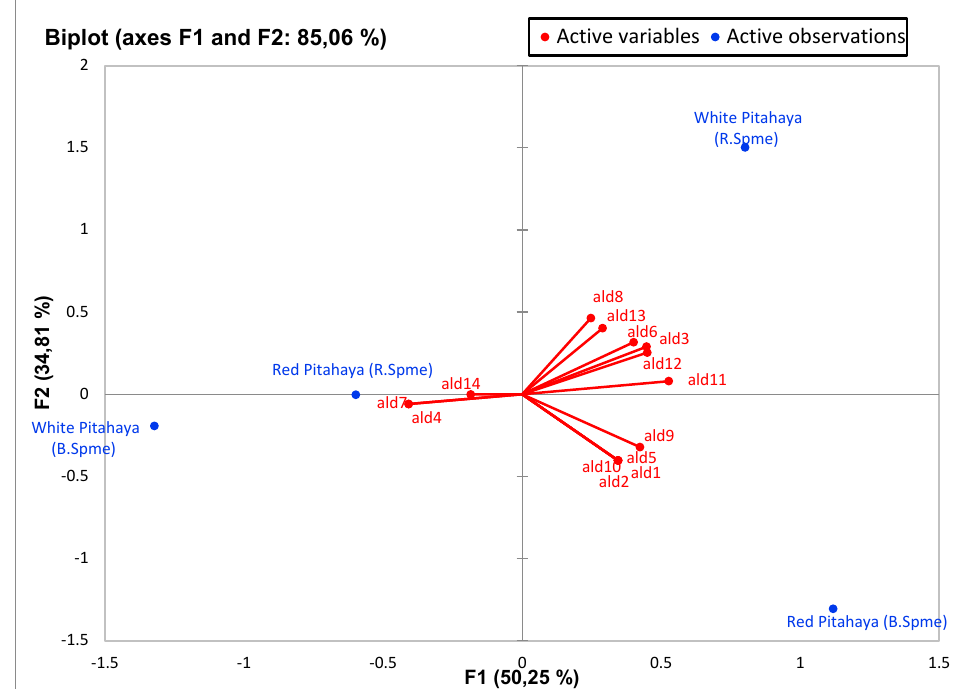
Biplot (axes F1 and F2: 85,06 %)